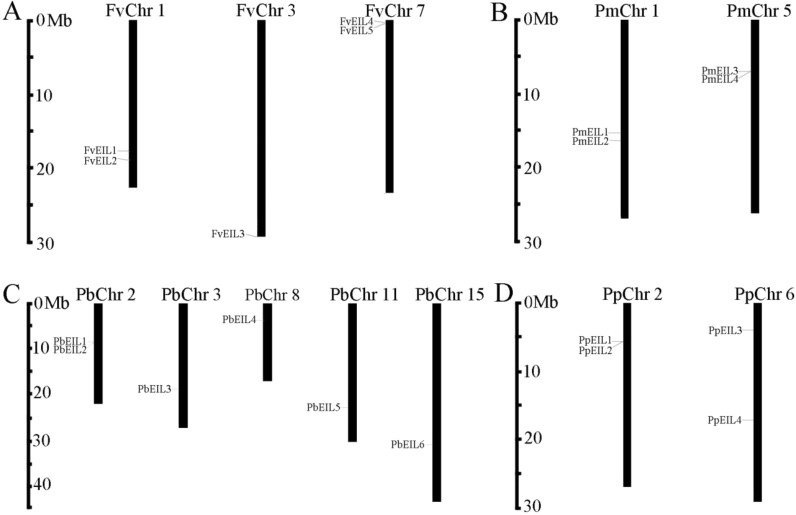
Chromosomal location of EIN3/EIL genes in the genomes of strawberry (A), mei (B), pear (C) and peach (D).The distribution of EIN3/EIL genes among the chromosomes in each species was diverse. The chromosome number was represented at the top of each chromosome. The left scale indicates the megabases (Mb).